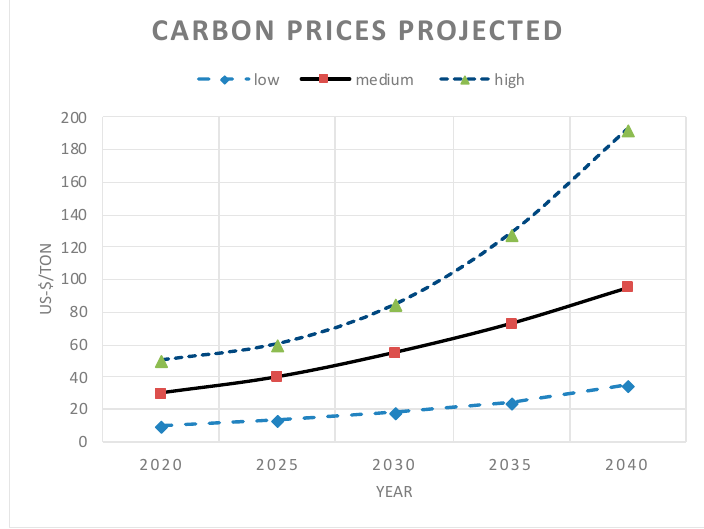
Figure 1. Different paths for CO 2 prices needed to limit temperature rise to 2.5 degrees Celsius.